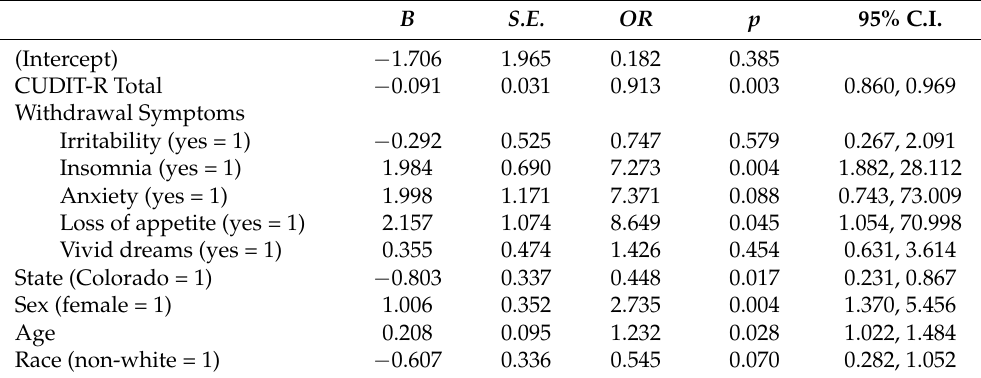
Table 3. Results of logistic regression predicting self-medication with CUDIT-R, sex, state, and specific withdrawal symptoms, controlling for age and race. (N =